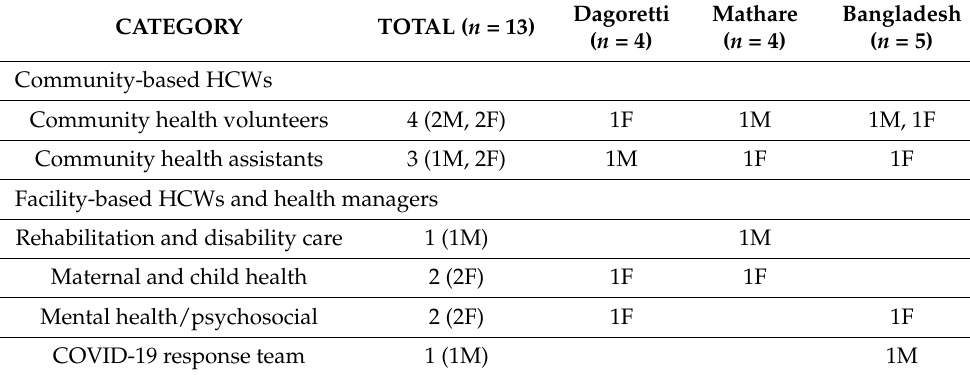
Table 1. Participants sampling